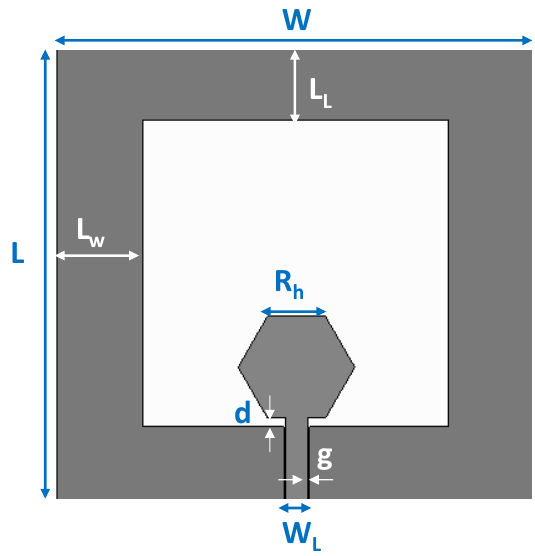
Figure 2. Geometry of the CPW-fed slot monopole antenna.